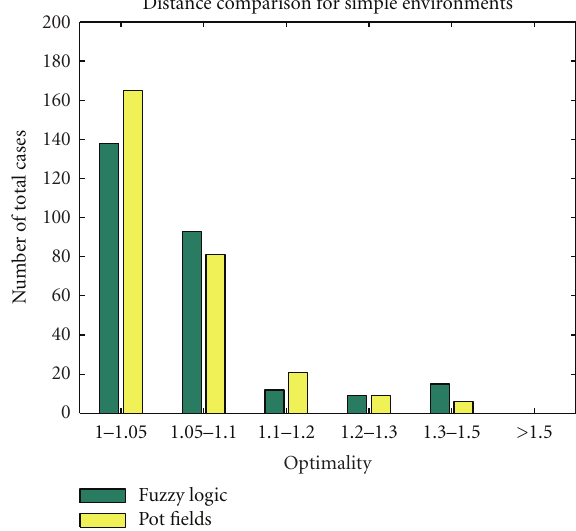
Figure 15: Controlled heading angle and actual heading angle ver- sus time of the example.